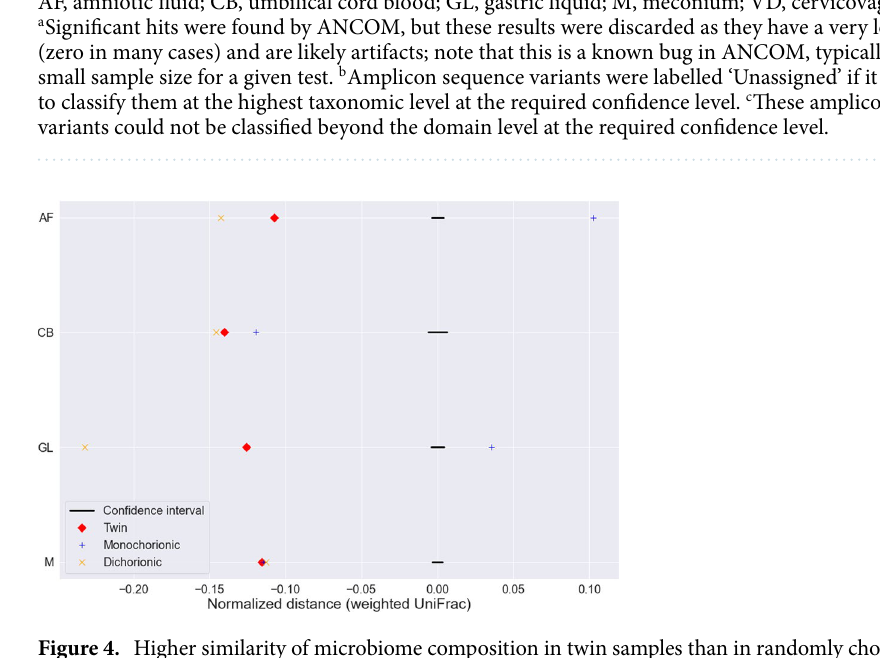
Figure 4. Higher similarity of microbiome composition in twin samples than in randomly chosen samples. For each sample type, the means of weighted UniFrac distances are shown for the twin samples. A 95% confidence interval was constructed by randomly sampling pairwise distances with replacement from the samples for 1000 times.